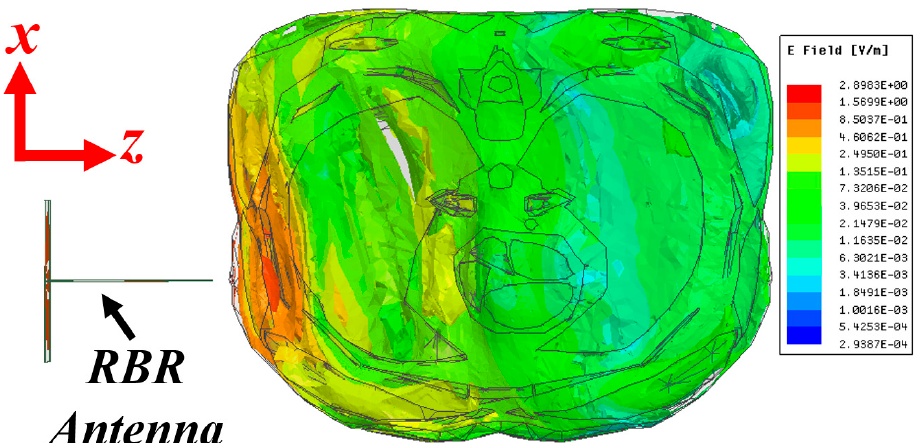
Figure 3. Calculated electric field density at sample frequency of 0.9 GHz.